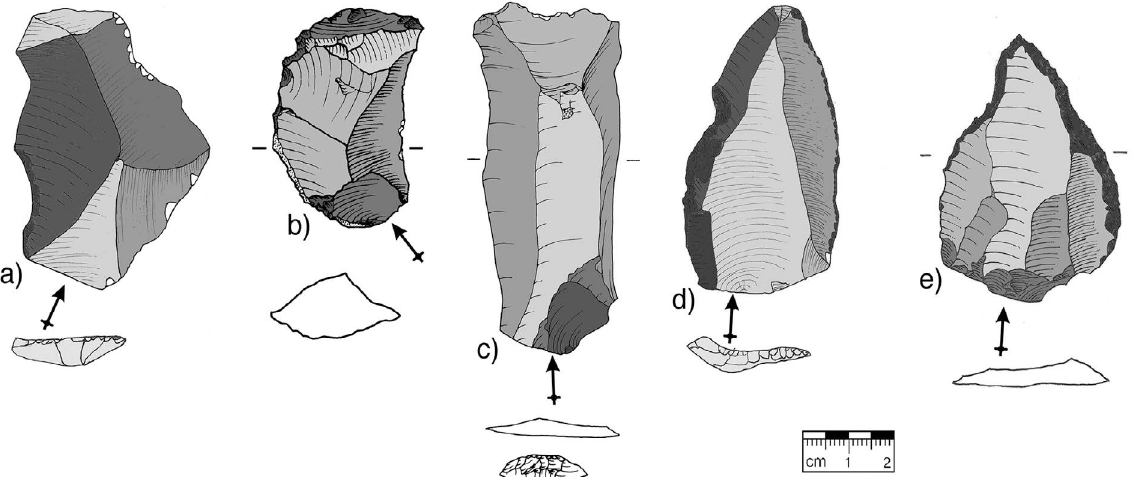
Figure 12: Examples of Levallois blanks from GH 3 (for grey scale see explanation for Figure 10). a) Levallois flake (GER10.227-058.336), b) Éclat débordant (GER12.225-058.268), c) Levallois blade (GER11.225-060.61), d) Marginal retouched Levallois point (GER10.226-059.261) and e) Constructed (retouched) point on Levallois flake (GER12.226-057.1200). The different grey shades correspond to subsequent reduction steps (the darker the younger, see Frick & Floss in press for a detailed